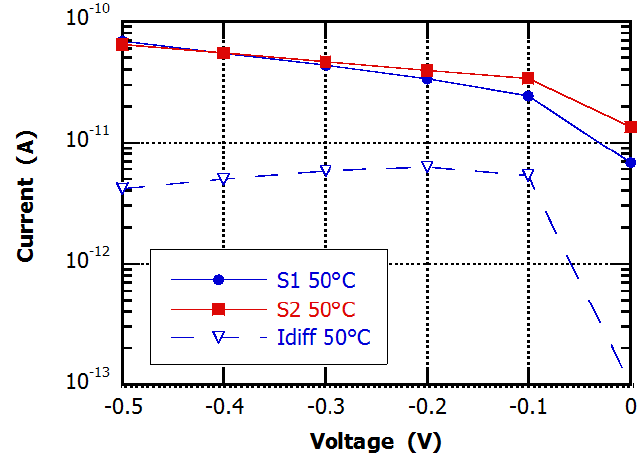
Figure 8. Current-voltage curves measured in dark conditions at 50 °C.